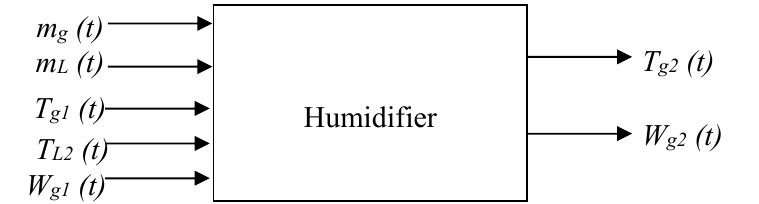
Figure 6. The input / output block diagram of the Figure 6. The input/output block diagram of the humidifier.